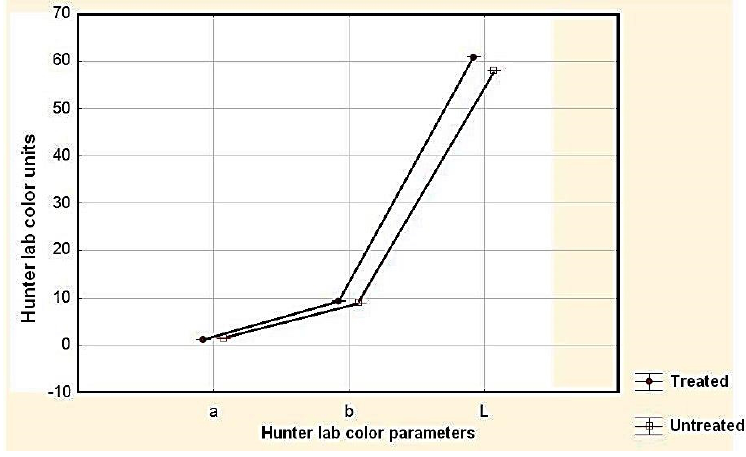
Fig. 1. Effect of adsorbent on color of waste oil. Lightness or L*, redness-greenness or a* and yellowness-blueness or b*. Bars represent the standard deviation